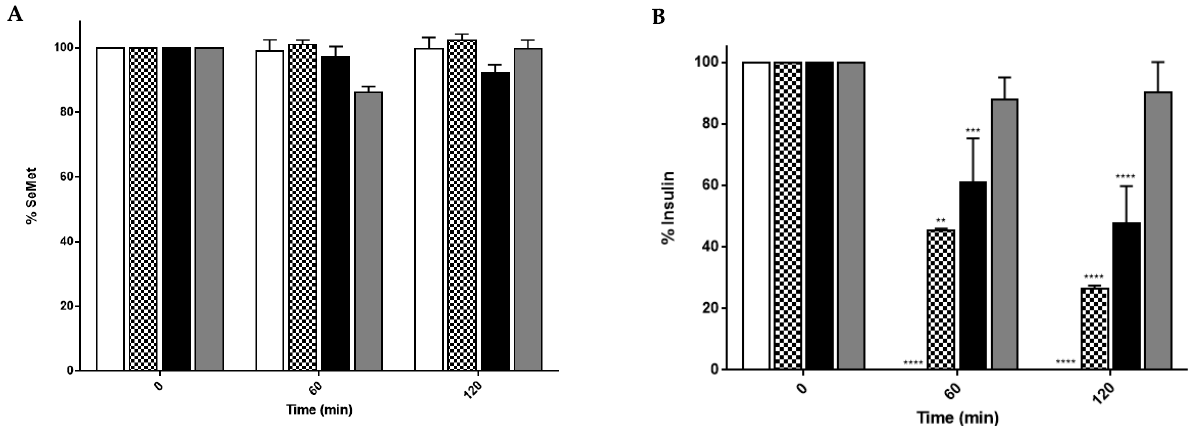
Figure 2. Stability of ( A ) SeMet (5 mM); ( B ) Recombinant human insulin (250 μM) in rat liver ho- mogenates (LH—White), gut homogenates (GH—Check) and gut washes (GW—Black) and PBS control (PBS—Grey) as measured by RP-HPLC. One-way ANOVA with Dunnett’s multiple compar- ison; ** p < 0.01, *** p < 0.001 and **** p < 0.0001, respectively, compared with analyte at 0 min. Each value represents the mean ± SEM, n = 3.